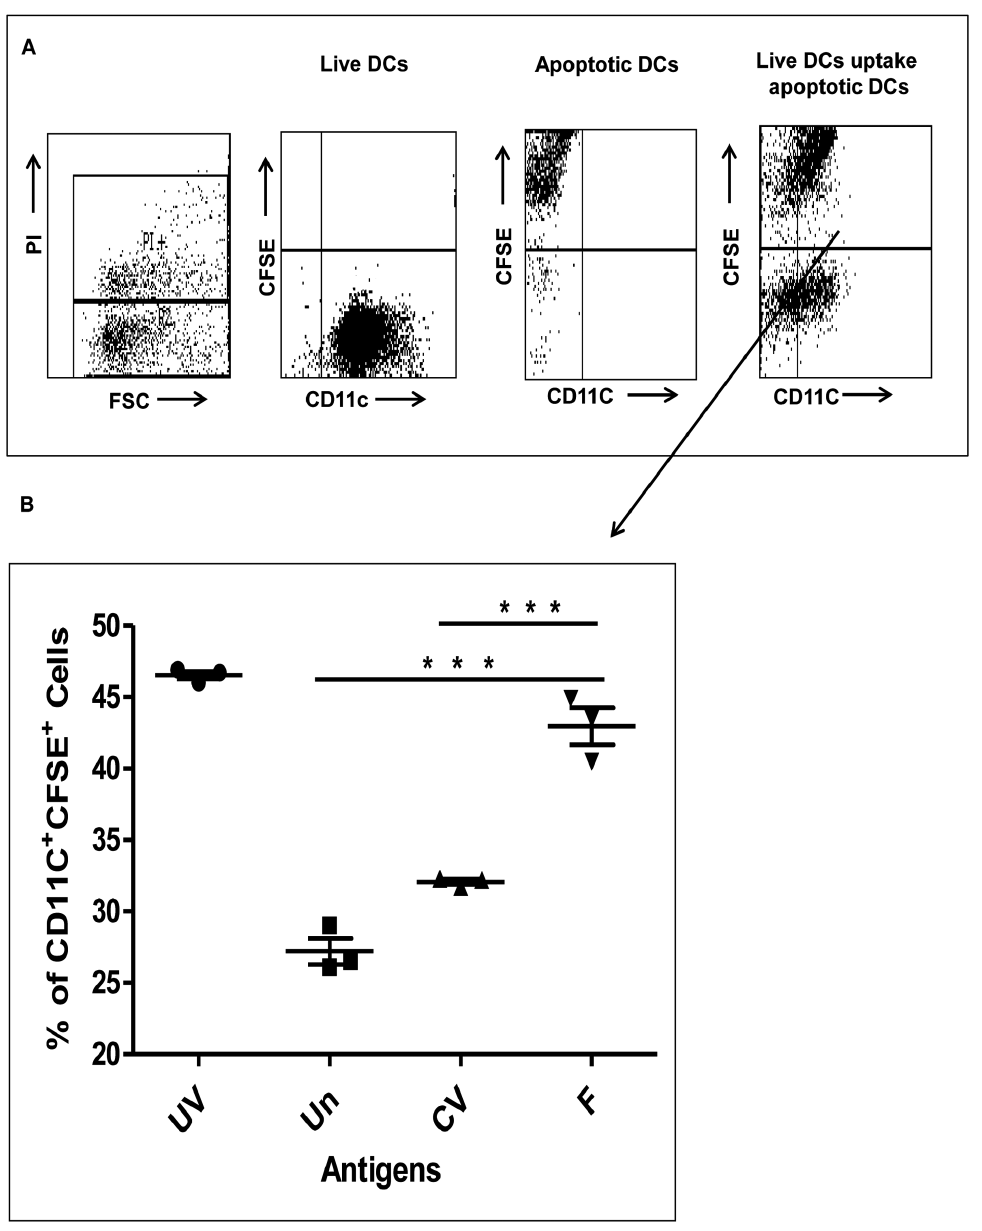
Figure 6. F-protein induced apoptotic DCs are efficiently taken up by live DCs invitro . CFSE-labelled apoptotic DCs were incubated with live immature DCs at a ratio of 1:1 for 2 hours. Flow cytometry analyses were conducted to assess uptake of CFSE + apoptotic DCs by live CD-11c + DCs. Double positive cells indicate the number of live DCs that have uptaken apoptotic DCs. (A) the gating pattern in different groups: live DCs were gated based on PI exclusion and CD-11c expression and the proportion of CFSE + cells was assessed among CD-11c + to determine the phagocytosed DCs. (B) CFSE + CD-11c + double positive cells are significantly higher in the F group which has more apoptotic DCs induced by rAd-F infection compared to control vector or untreated DCs. UV treated DCs were used as positive controls for apoptotic DCs. Data are representative of three different experiments.